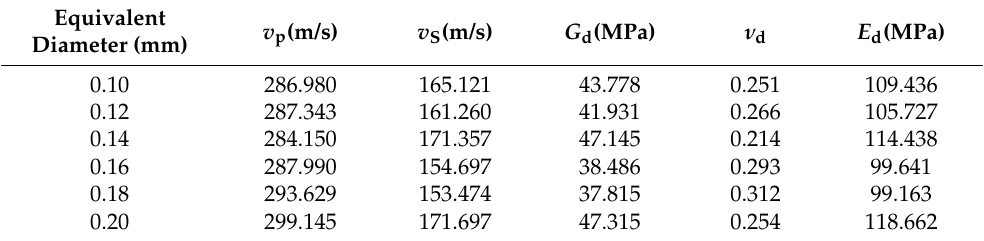
Table 4. Macroscopic dynamic response of different equivalent diameters of pores.